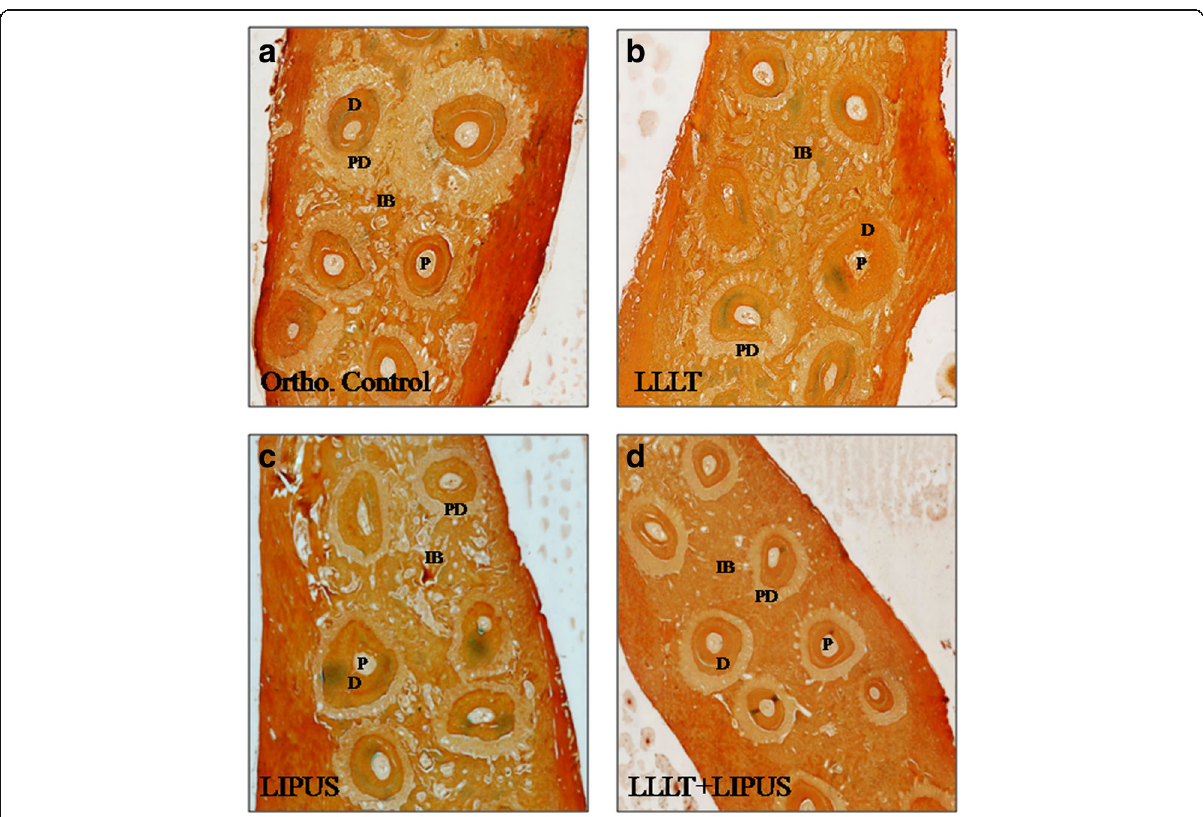
Fig. 8 Light micrographs of rat ’ s maxilla portions with orthodontically induced tooth movement for 21 days. There was higher amount of interseptal bone between the roots of the teeth in the treatment groups in relation to the orthodontic control group which also showed wider periodontal ligaments. Between the treatment groups, the interseptal bone was highest in the combination group, followed by the LLLT group and then the LIPUS group, sections stained with alizarin red and Alcian Blue specialized staining. × 10. a Orthodontic control, b treated with 100 mW LLLT, c treated with LIPUS, and d treated with 100 mW LLLT + LIPUS. P : pulp, IB : interseptal bone, PDL : periodontal ligament, D :